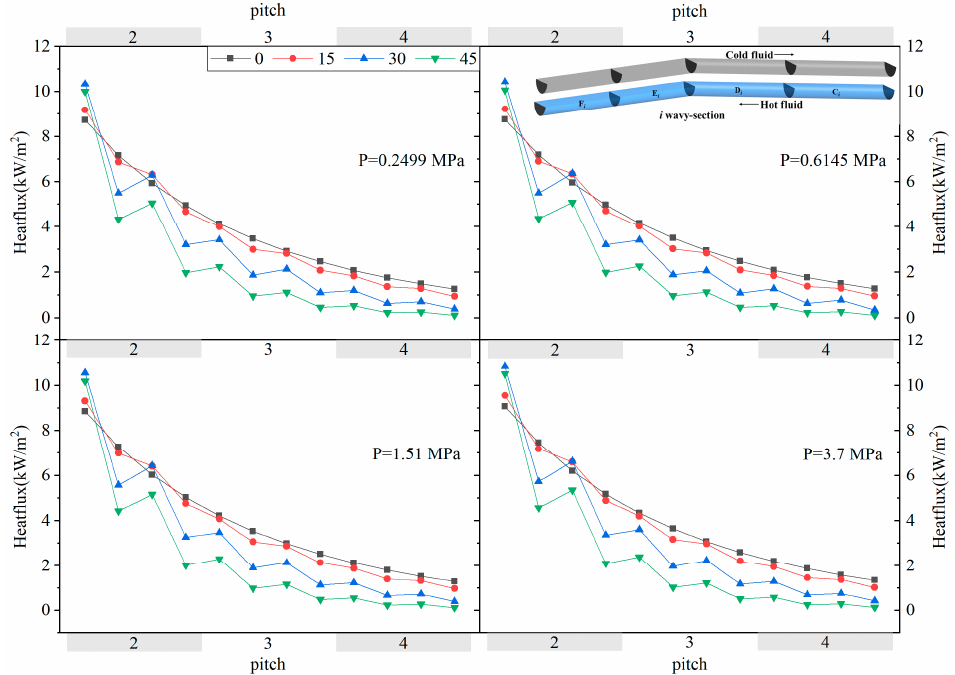
Figure 11. The heat flux distribution of hot fluid. Additionally, it was found that, along the hot fluid flow direction, the heat flux of the straight channel smoothly decreased, but the heat flux of the wavy channel showed a different trend. As seen in the figure, the heat flux of E i was greater than that of D i , and the difference between the maxima and minima of the heat flux was smaller when the angle was smaller. This also confirms the conclusion that the flow direction changes in the wavy channel can enhance the heat